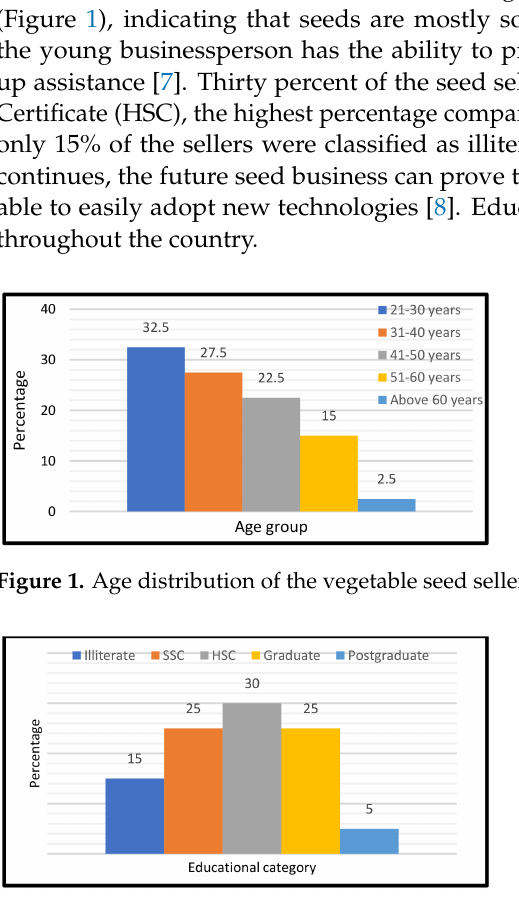
Figure 2. Educational background of the vegetable seed